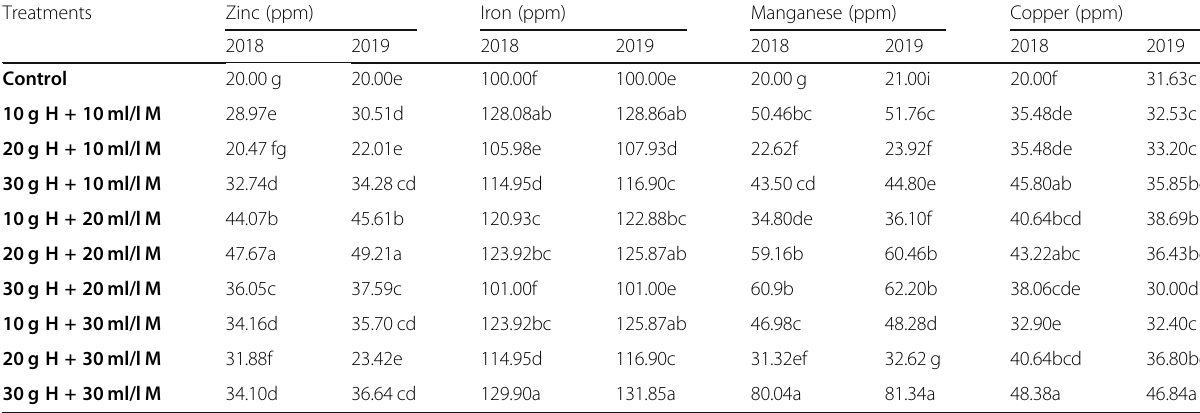
Table 5 Effect of soil application with humic acid and foliar spray of milagro on some leaf micro element contents